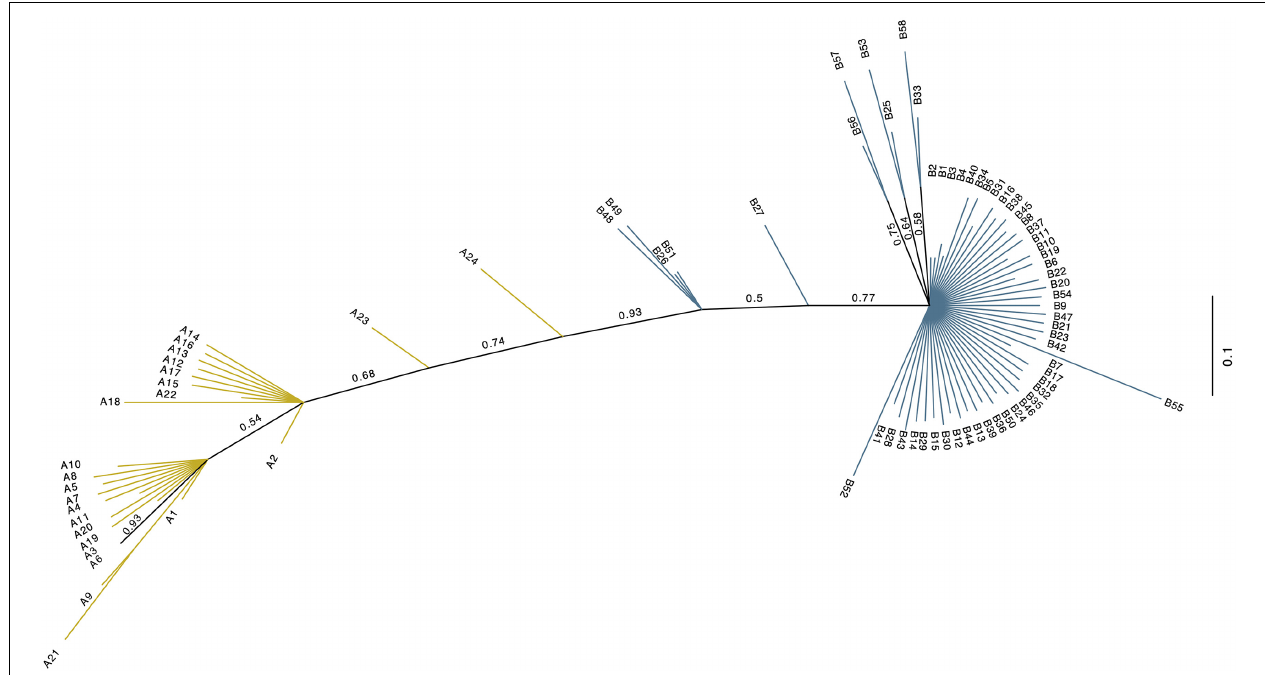
FIGURE 2 | Unrooted phylogenetic tree of the 82 dromedary camel haplotypes. The new haplotype naming system based on this study. Values above branches are posterior probabilities (PP). Blue branch lines indicate haplogroup B sequences with posterior probability values = 1, while the yellow line designate haplogroup A sequences with a posterior probability = 1. Branches colored in black have PP values <